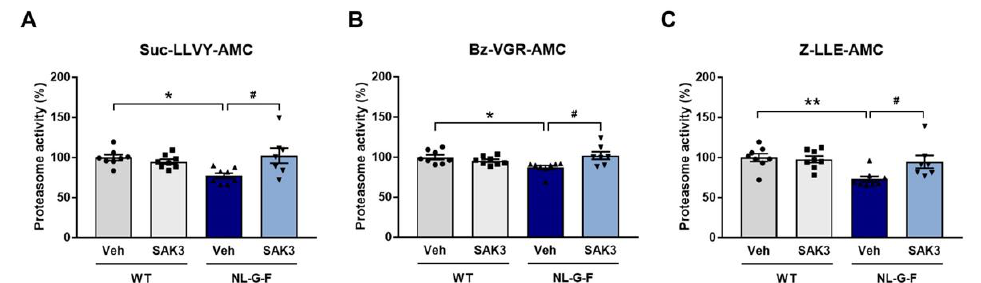
Figure 2. SAK3administrationrescuesthedecreaseinproteasomeactivityinNL-G-Fmice. ( A )Proteasome activity assay using the fluorogenic peptides Suc-LLVY-AMC (chymotrypsin-like); ( B ) Bz-VGR-AMC (trypsin-like), and ( C ) Z-LLE-AMC (caspase-like) using brain homogenates from the cortical region ( n = 7–8 per group); Suc-LLVY-AMC: F (3, 27) = 4.814, p < 0.01; Bz-VGR-AMC: F (3, 27) = 4.555, p < 0.05; Z-LLE-AMC: F (3, 27) = 5.795, p < 0.01. Error bars represent standard error of the mean (SEM). * p < 0.05, ** p < 0.01 vs. vehicle-treated WT mice; # p < 0.05 vs. vehicle-treated NL-G-F mice. The symbols (solid dots, squares, triangles and inverted triangle) indicate the individual